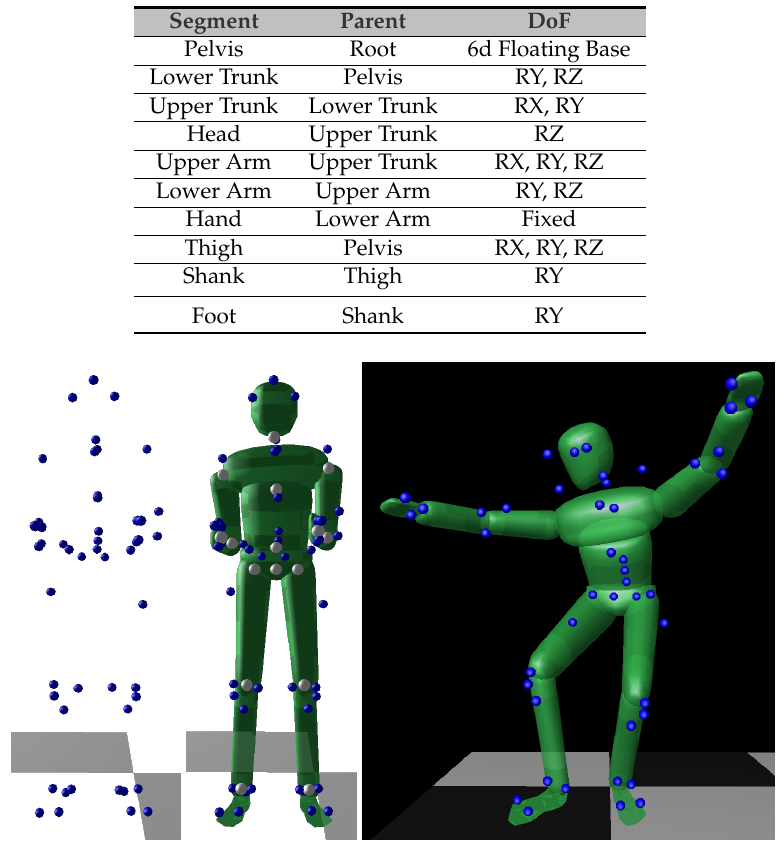
Figure 3. Left: The static pose of the subject. Middle: The rigid body model in Puppeteer. Joint centers are visualized in white. Virtual markers were placed on the model following the static pose. Right: Inverse kinematic fit of the model to a slackline